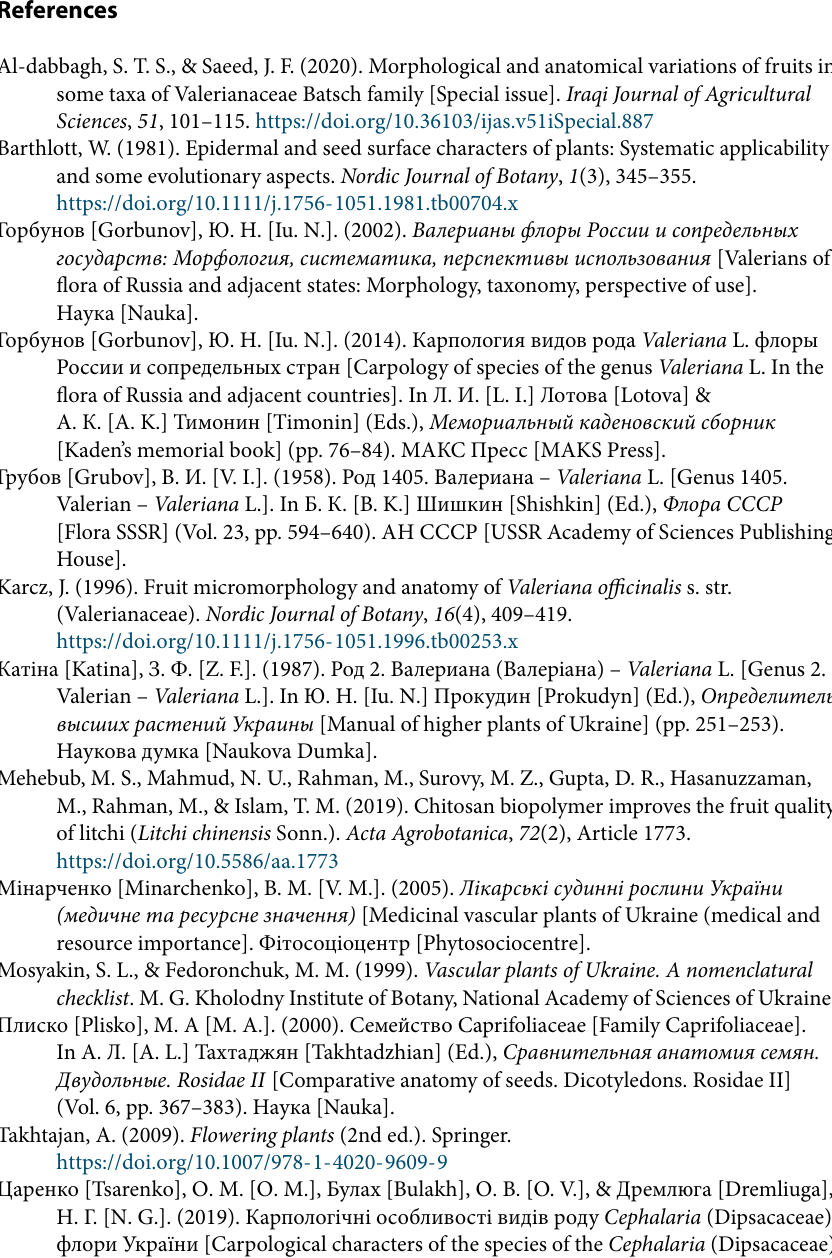
Table S1. Herbarium specimens of species of the genus Valeriana used for the study of fruits using